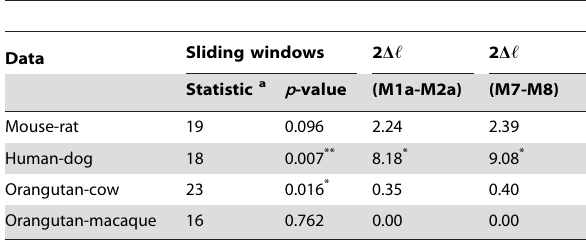
Table 1. Test of sites under positive selection by the sliding- windows analysis and by the LRT.